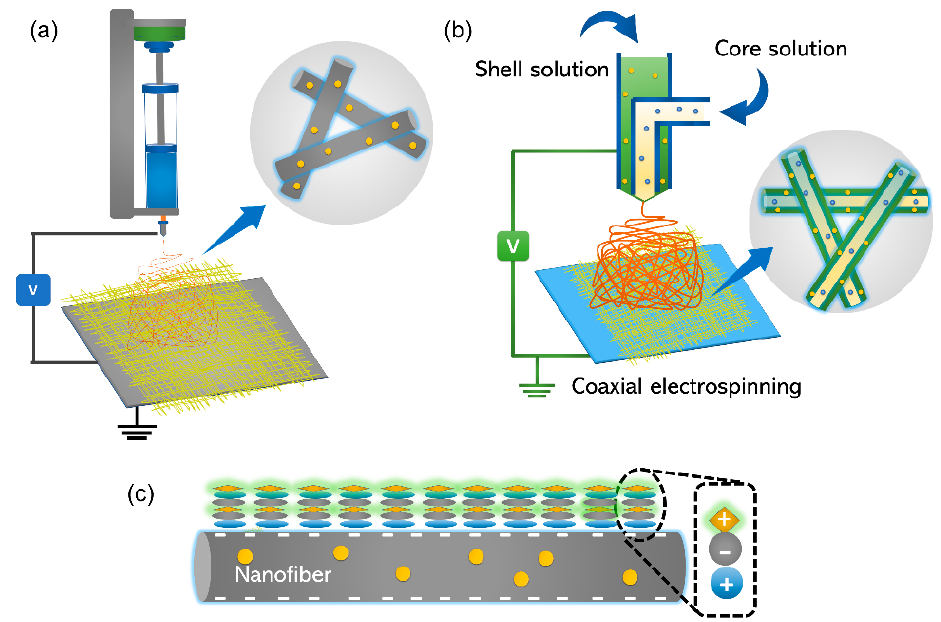
Figure 2. Schematic of preparation of ( a ) blended NFs using electrospinning, ( b ) core-shell NFs using coaxial electrospinning, and ( c ) layer-by-layer assembly as DDSs.